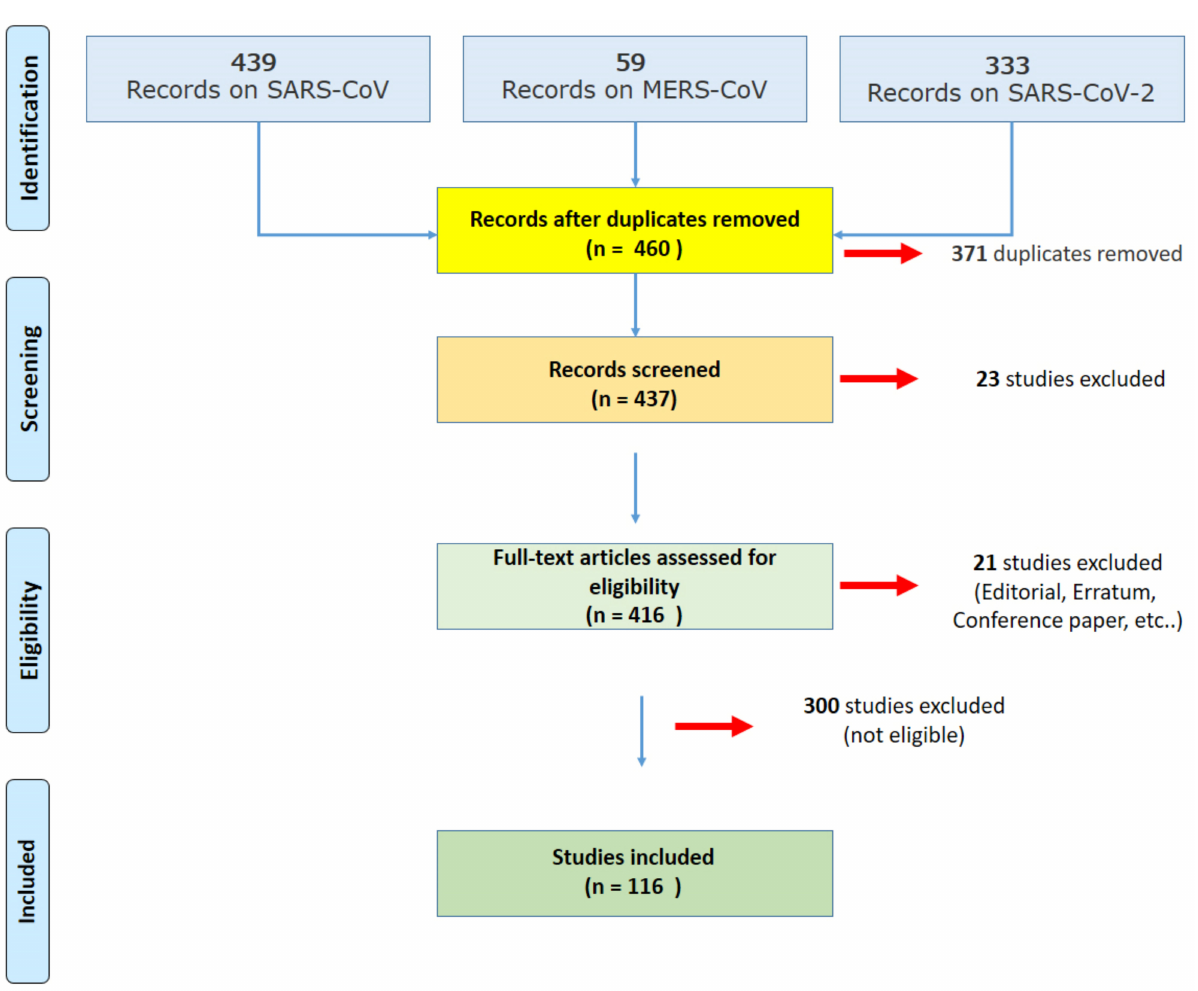
Figure 1. The PRISMA (Preferred Reporting Items for Systematic Reviews and Meta-Analyses) strategy used for the literature